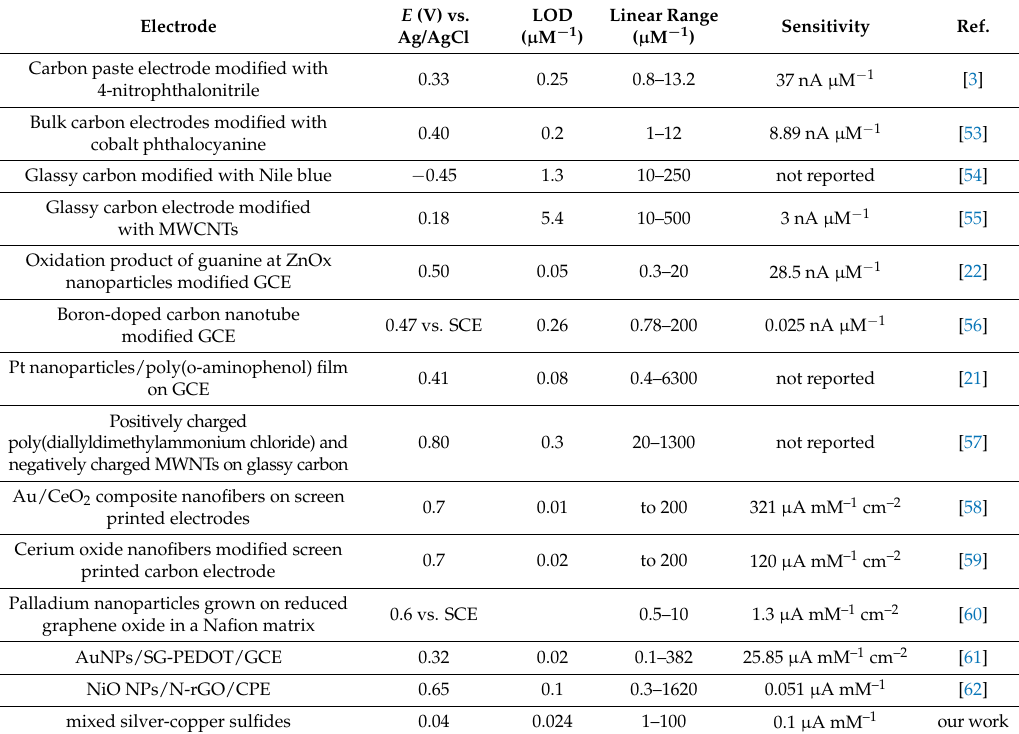
Figure 8. Amperometric responses of the electrode “ACS” to successive addition of the possible interferences. Initial concentration of cysteine was 30 µ M. Measurements were performed in 90 mL 0.1 KNO 3 + 10 mL 0.1 M phosphate buffer pH 7, at the 0.04 V. Table 3. Comparison of the analytical performances of various reported electrodes for the amperometric determination of